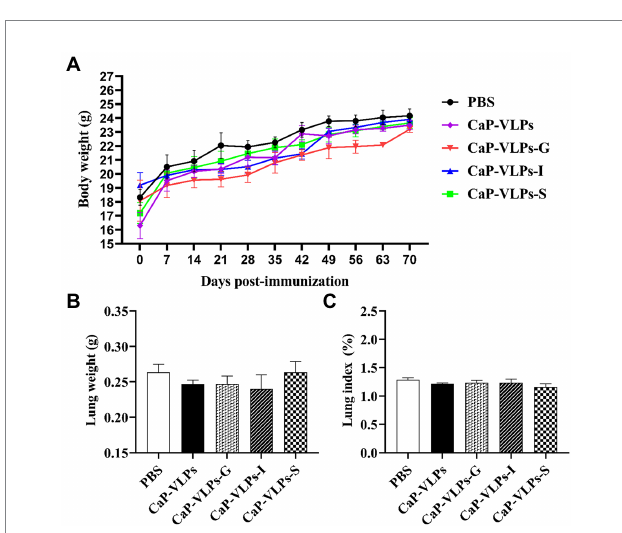
FIGURE 5 Changes in lung macroscopic parameters in mice on day 28 after the first immunization. (A) Weight change in mice. (B) The lung weight. (C) The lung